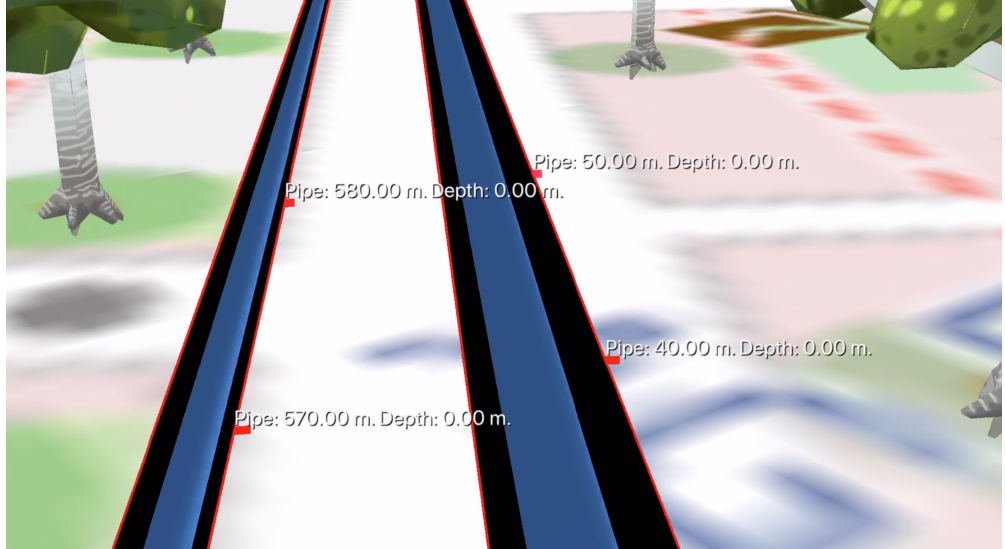
Figure 17. Ditch highlighted with borders to enhance depth perception. Evenly spaced tick marks along pipes and cables also provide further information to the